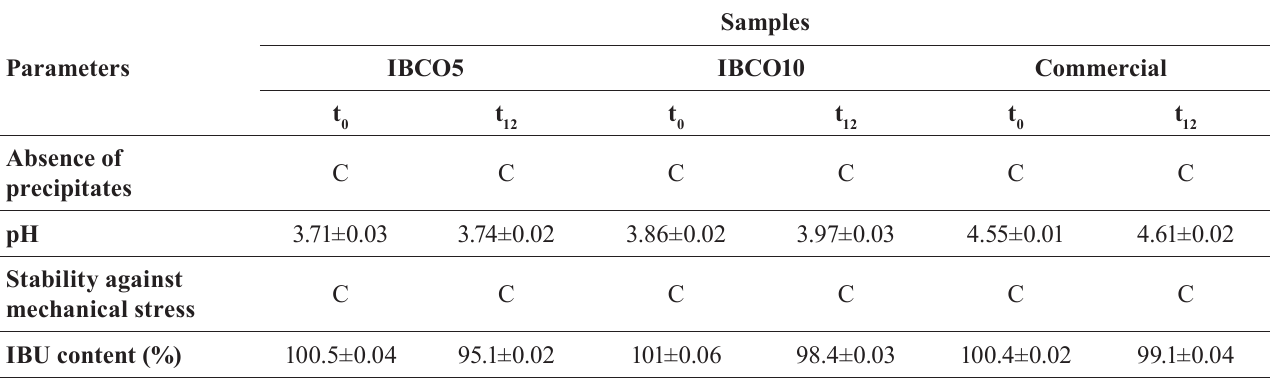
TABLE II - Preliminary stability studies of formulations after heat stress